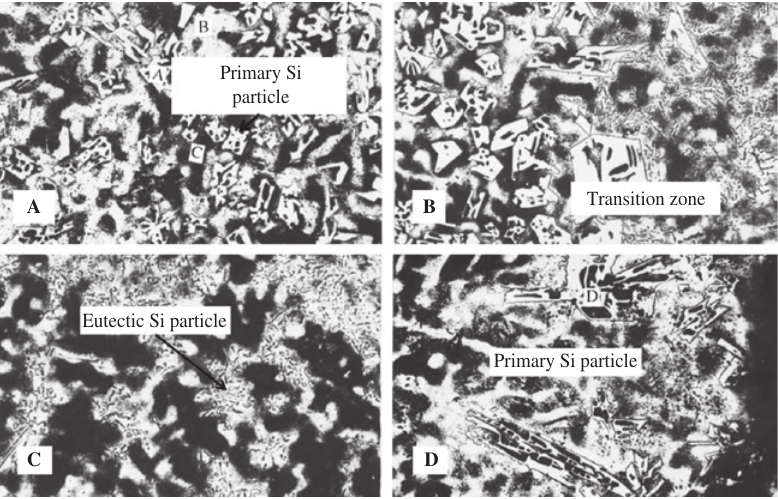
Figure 29: Microstructures at different positions of the centrifugal cast Al-Mg the middle area [93].